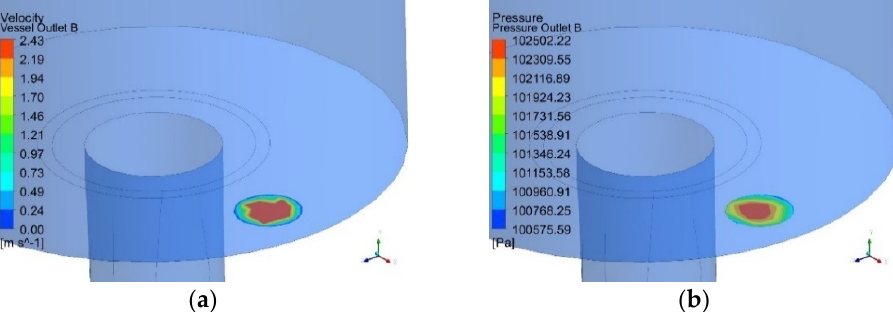
Figure 12. Outlet location, ( a ) Velocity outlet, ( b ) Pressure Outlet.